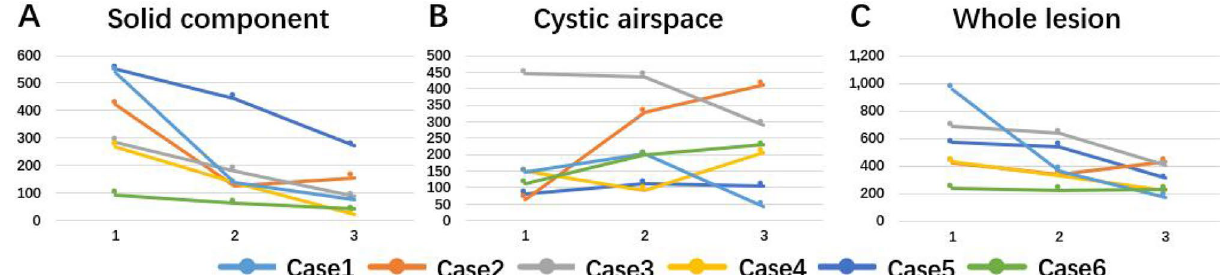
Figure 4. Changes in maximum area of different components after NC in six cases. The first abscissa represents the initial CT examination (Baseline) before NC, the second abscissa represents the first CT examination (First Time) during NC, and the last abscissa represents the last CT examination (Last Time) after NC. ( A ) Solid component; ( B ) cystic airspace; ( C ) whole